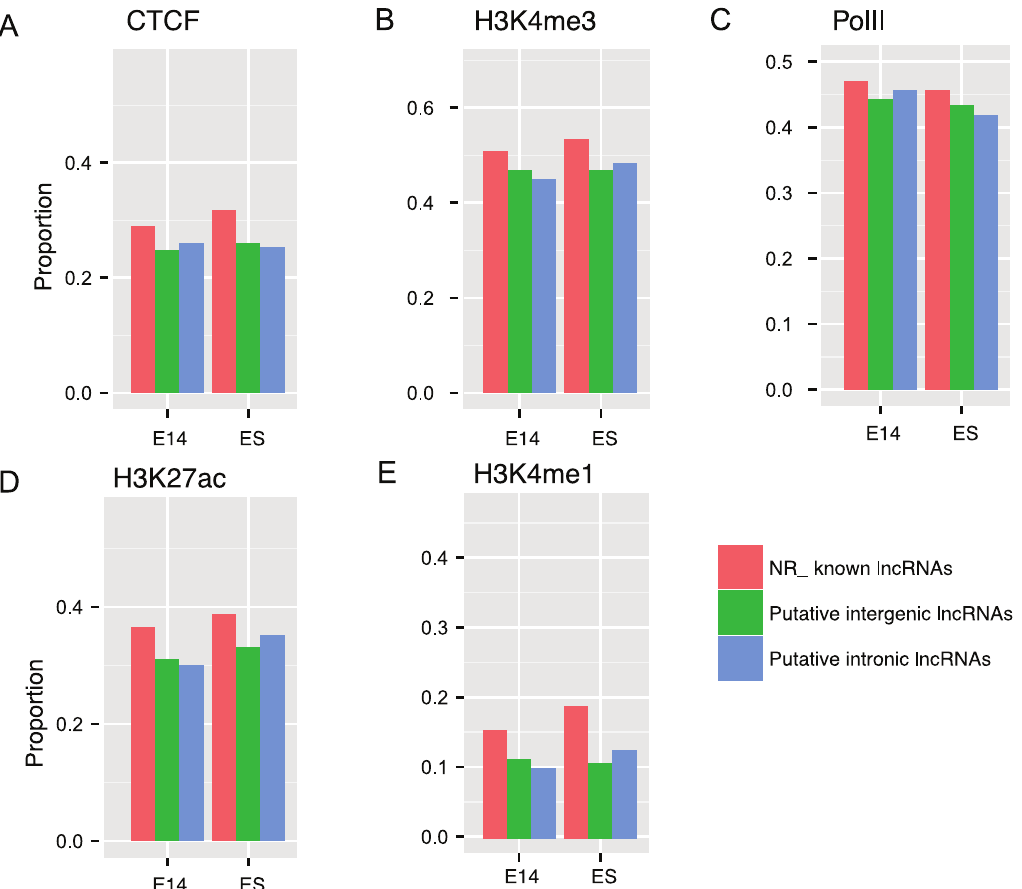
Figure 5. Proportions of lncRNAs that overlap with chromatin marks in TSS-proximal regions for all known long non-coding RNAs and putative lncRNAs, respectively. We analyzed ChIP-seq data of five representative chromatin marks for putative embryonic brain lncRNAs, that is (A) CTCF, (B) H3K4me3, (C) PolII, (D) H3K27ac and (E) H3K4me1. ChIP-seq tags are aligned to the mouse genome (mm9) by Bowtie and then are used to perform peak calling by MACS. Enriched chromatin domains for five chromatin modifications are intersected with putative and known lncRNAs by comparing genomic coordinates. Proportions of overlapped (at least 50% of lncRNA length) lncRNAs are defined by proportions of any peaks of specific marks in TSS-proximal regions (5k upstream and 5k downstream of TSSs) for known long non-coding RNAs and putative lncRNAs, respectively. We restrict this analysis to intergenic and intronic lncRNAs since unambiguous assignment of chromatin marks to the cis-antisense lncRNAs can be confounded by their exonic overlapping genes. NR_, known long RefSeq genes; E14_, embryonic E14.5